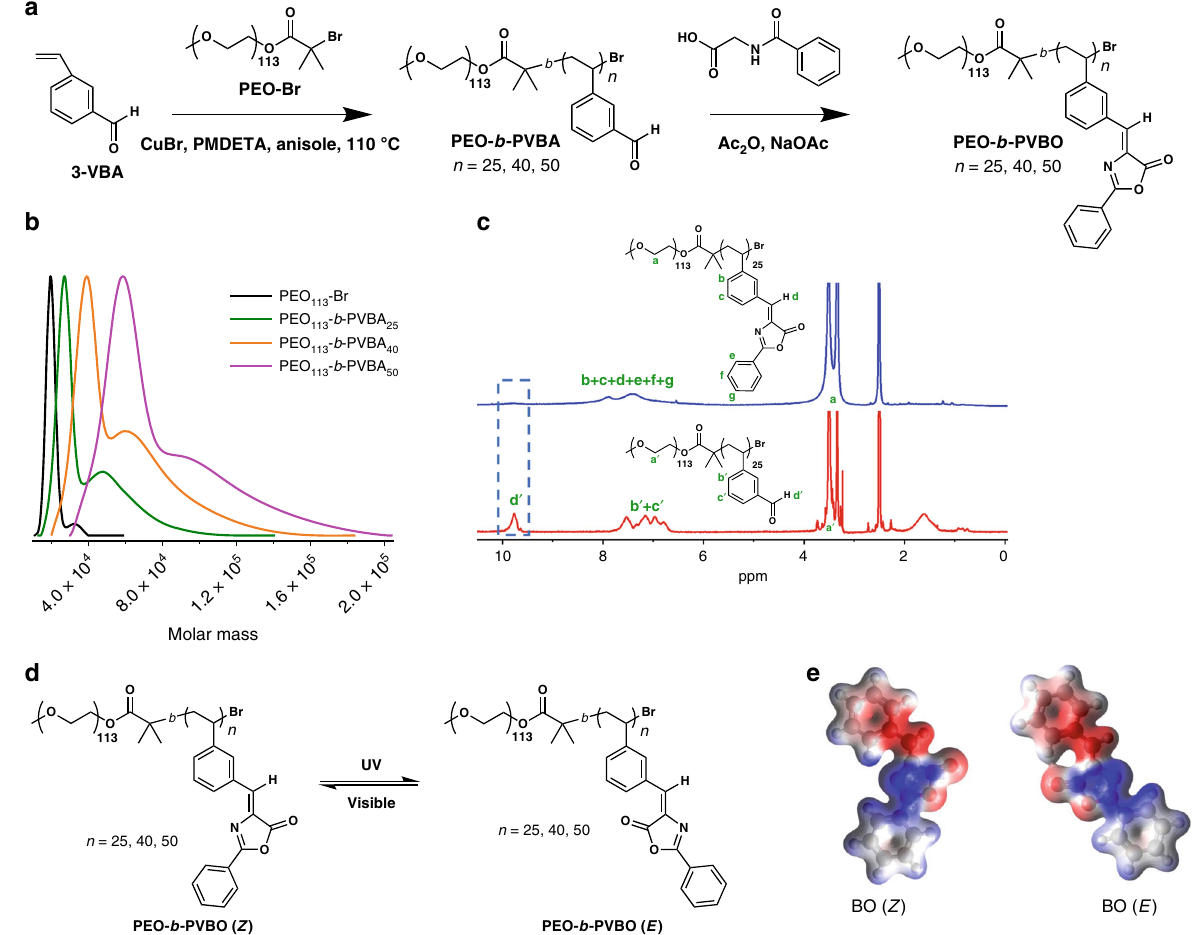
Fig. 1 Synthesis and characterization of PEO- b -PVBOs. a Synthesis of block copolymers with pendant BOs. b Overlaid GPC traces of PEO-Br and a series of PEO- b -PVBA block copolymers. c 1 H NMR spectra of PEO 113 - b -PVBA 25 (red) and PEO 113 - b -PVBO 25 (blue). d Light-induced isomerization between PEO- b -PVBO ( Z ) and PEO- b -PVBO ( E ) under alternating UV and visible light irradiation. e Energy density mapping of the isomers calculated at the B3LYP/6-311 + G(d,p) level of